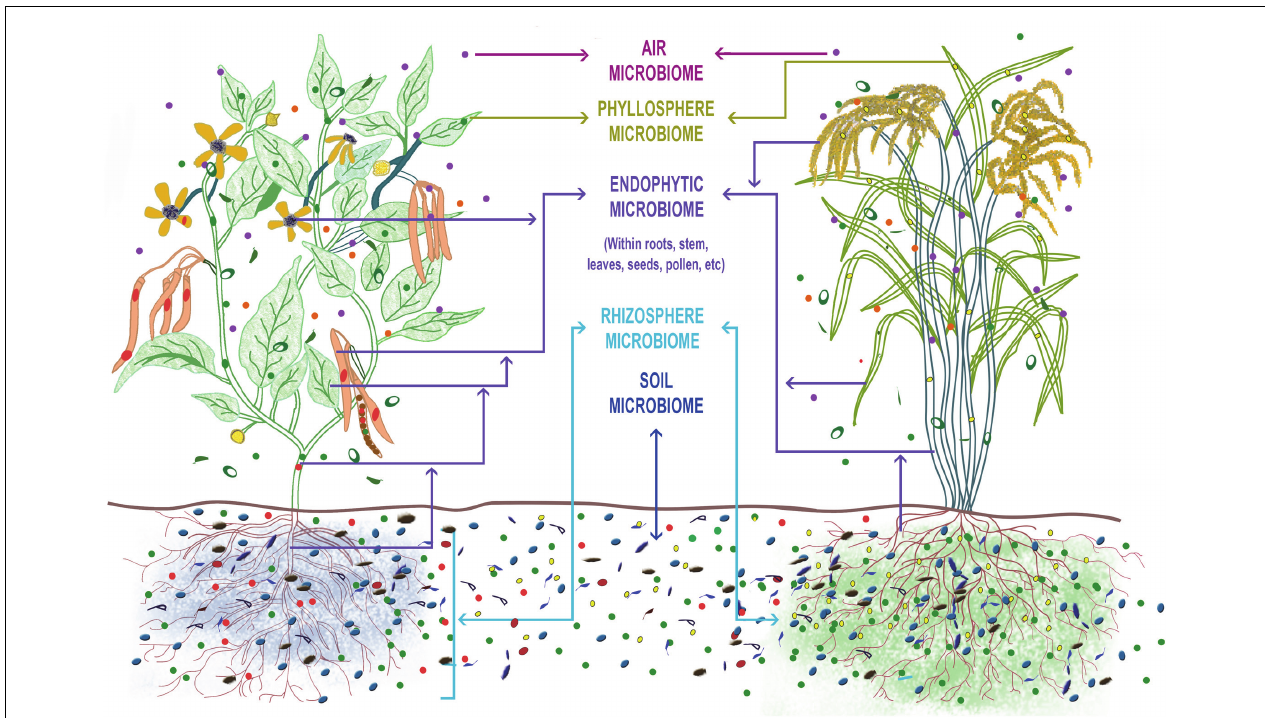
FIGURE 1 | The ‘Plant Microbiome’ can be described as the sum total of the genomic contribution made by the diverse microbial communities that inhabit the surface and internal tissues of the plant parts. The rhizosphere, endosphere, phyllosphere constitute the major compartments in which the microbial communities reside in the plant. The soil microbiome is the main source from which the plant selects and builds its microbiome profile. The plant genotype (e.g., dicot bean plant and a monocot rice plant), its root exudates (indicated by blue shade for bean and green for rice), the soil types and properties, and the environmental factors influence the plant microbiome makeup (indicated by different colored microbes inhabiting the plant compartments in bean and rice plant). Mycorrhizal association in both plants is indicated by thin lines extending from the roots into the surrounding